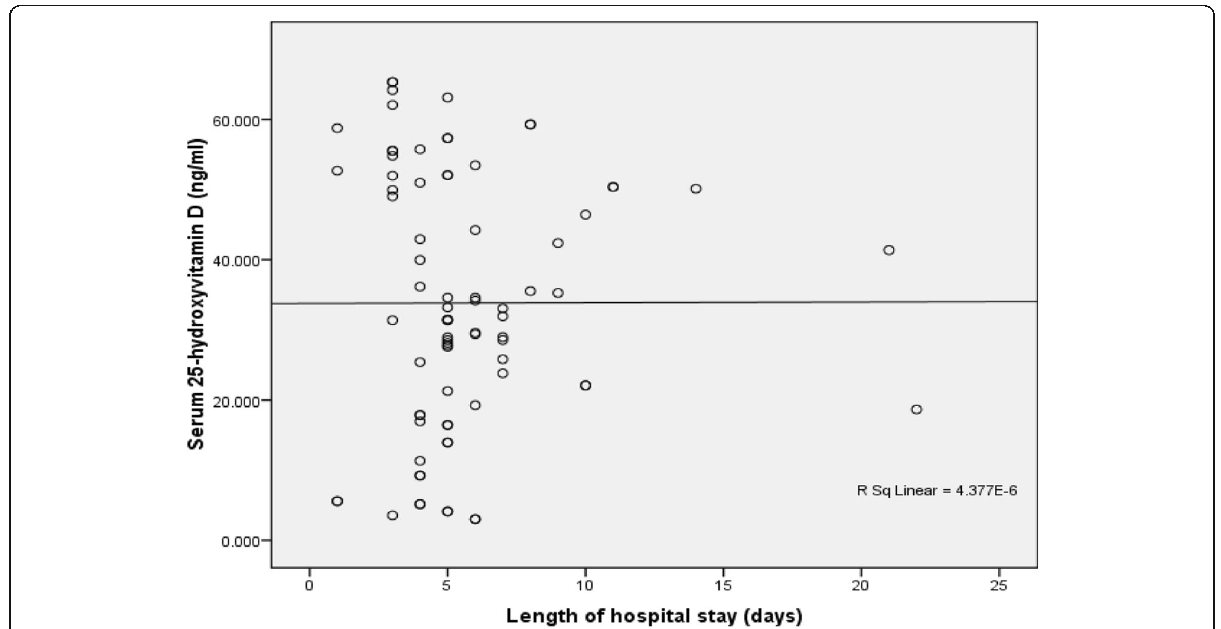
Fig. 3 Scattered plot of serum vitamin D and length of hospital